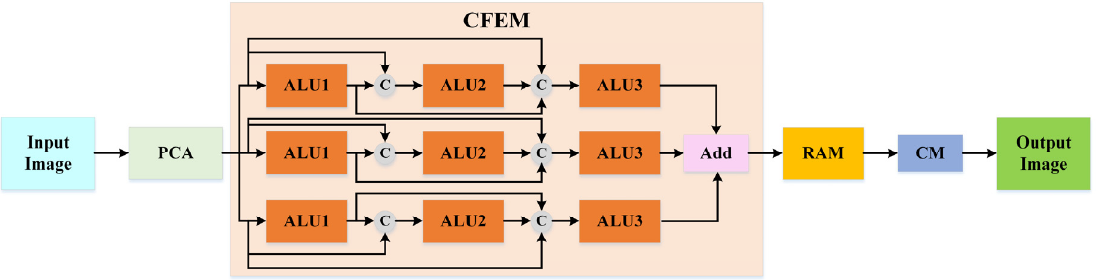
Figure 1. The overall architecture of the developed MCFANet model.